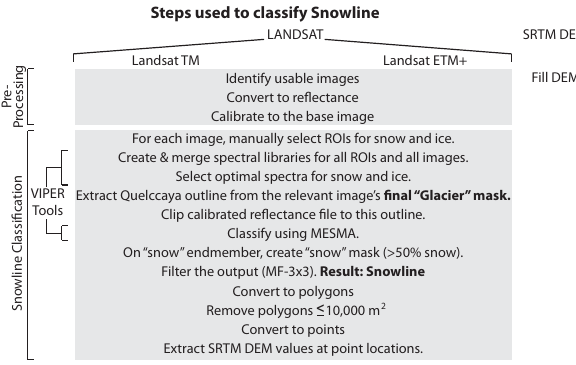
Fig. 6. Steps summarizing the processes used to classify glacial out- lines. As with Fig. 4, grey background overlaps those data sets to which each process applies, and bold text indicates important steps or data sets.